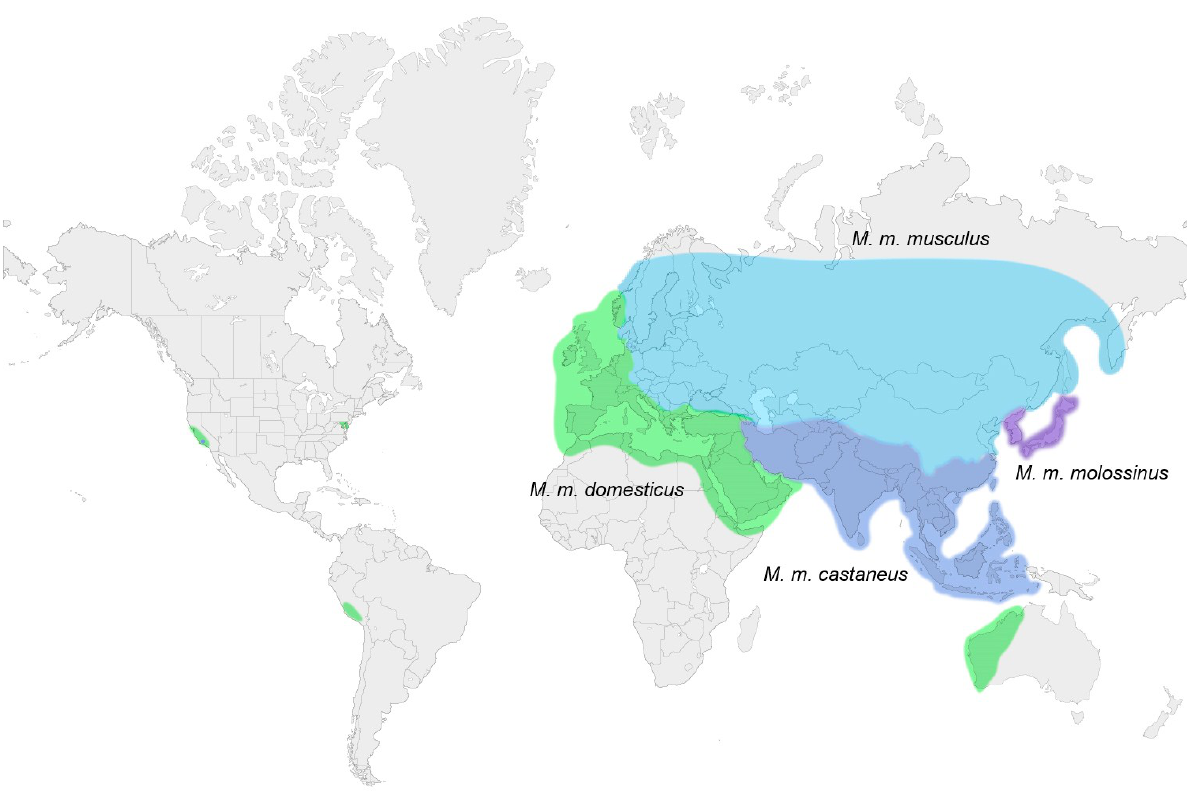
Figure 2. Geographic distribution of XP-MuLV infected house mouse subspecies. The three blue color blocks represent the ranges of the three subspecies carrying predominantly X-MuLVs; green represents P-MuLV infected M. m. domesticus . Wild-caught American house mice are largely domesticus